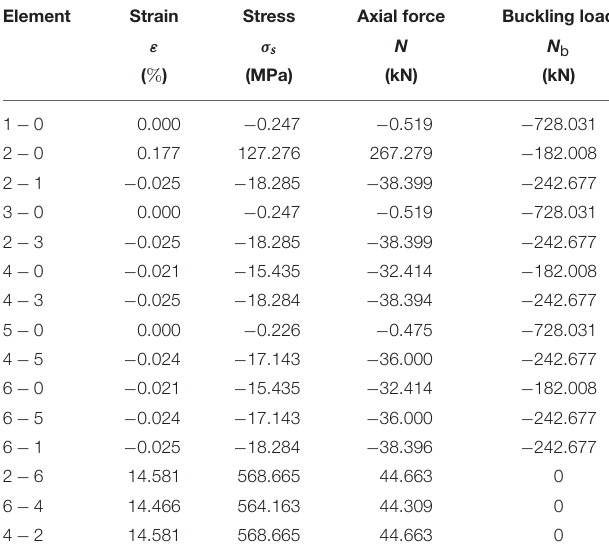
TABLE 6 | Strains, stresses and axial forces produced by the application of negative wind pressure forces on the TABS configuration corresponding to U 0.95 U =